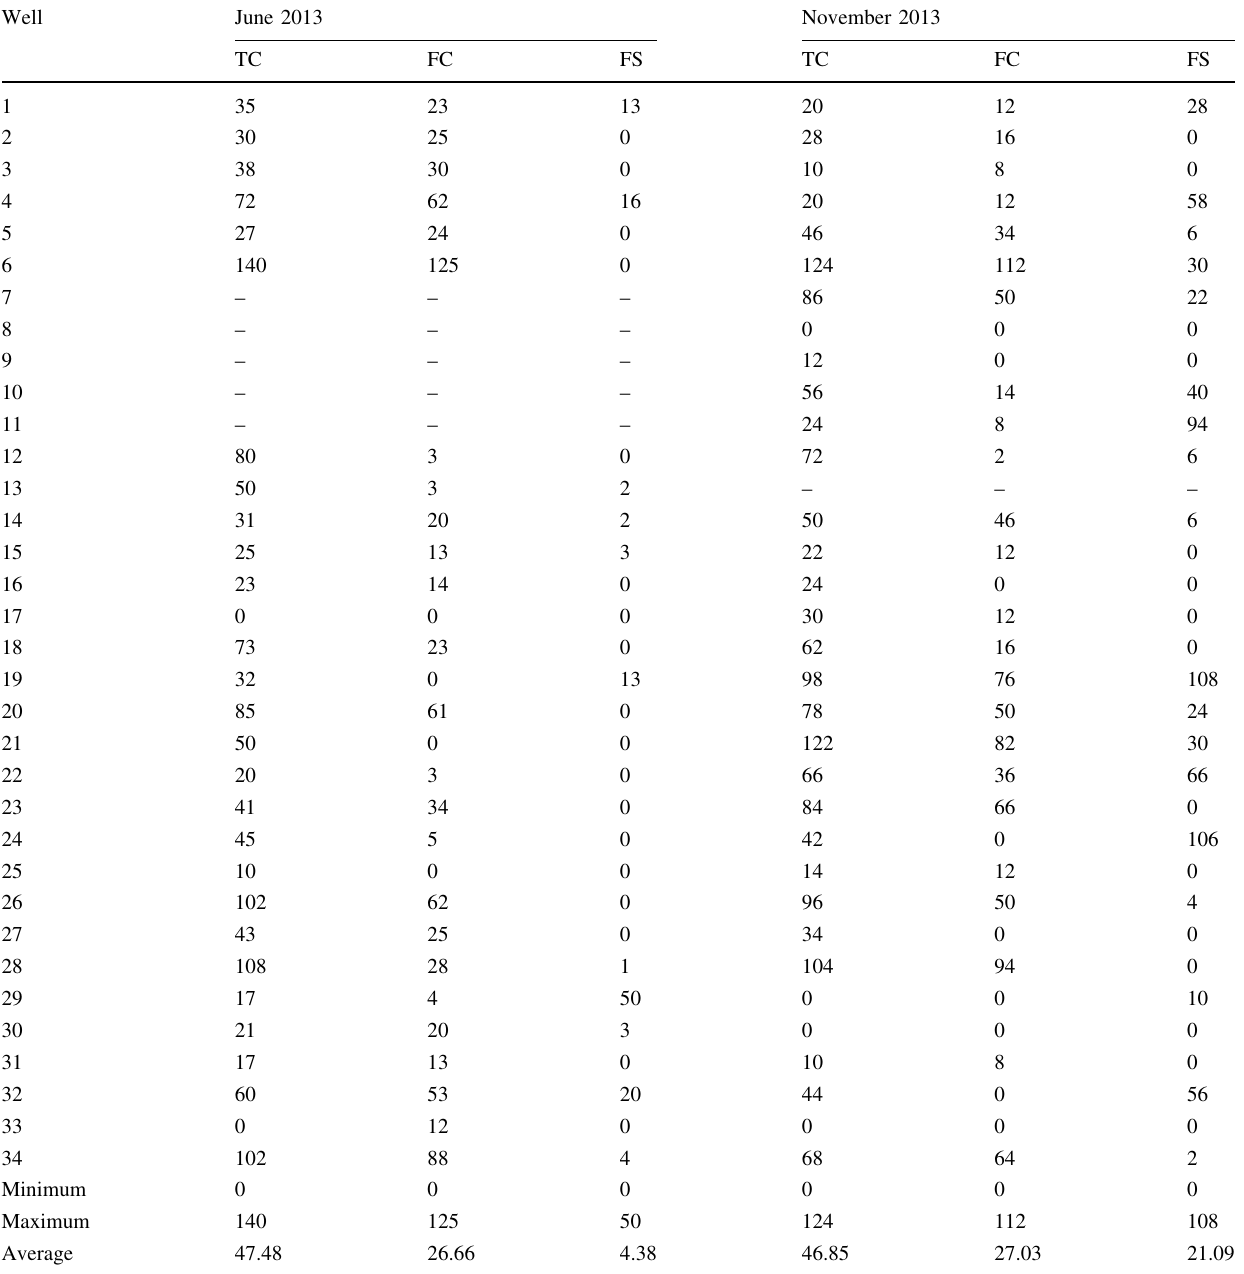
Table 1 Total Coliforms (TC), Fecal coliforms (FC), and Fecal Streptococci (FS) as colony forming units per 100 ml values measured in June 2013 and November 2013